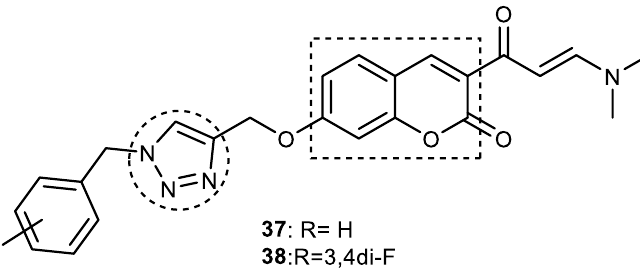
Figure 14. Chemical structure of coumarin – 1,2,3-triazole hybrids. Pourabdi et al., 2022, reported the synthesis, anti-ChE, 15-lipooxygenase (15-LOX), anti-A β aggregation, and neuroprotective activity of a novel series of 3-arylcoumarin derivatives linked to an N -benzyl 1,2,3-triazole ring system. They tried to obtain coumarin– 1,2,3-triazole hybrids capable of exhibiting LOX inhibitory activity in addition to the ChE/neuroprotection/antioxidant activity. It was hypothesized that 3-arylcoumarins with suitable hydrophobic aryl rings are more likely to bind the LOX through hydrophobic interactions [94]. Hence, in an attempt to obtain MTDLs, their group conjugated two bioac- tive moieties into one structure, viz., 3-arylcoumarin linked with N -benzyl 1,2,3-triazole bearing some pharmacophoric groups known to augment/exhibit anti-ChE activity [95]. Hybrid compounds were synthesized in four steps. Azides for the final step were generated in situ from corresponding benzyl halides. A one-pot, three-component click chemistry reaction (CuAAC) was used to synthesize coumarin-linked 1,2,3-triazole hybrids. Syn- thesized hybrids displayed very weak anti-AChE activity; however, they were found to be weak to a moderate inhibitor of eq BuChE (IC 50 = 6.7–36.5 µ M) in comparison with tacrine (IC 50 = 0.073 ± 0.009 µ M). Among the unsubstituted/substituted coumarins, the 8-methoxy group substituted coumarin, namely, 3-(4-((1-(4-chlorobenzyl)-1 H -1,2,3-triazol- 4-yl) methoxy)phenyl)-8-methoxy-2 H -chromen-2-one ( 43 ) and the 6-nitrocoumarin deriva- tive 3-(4-((1-benzyl-1 H -1,2,3-triazol-4-yl)methoxy) phenyl)-6-nitro-2 H -chromen-2-one ( 46 ), showed the best anti-BuChE activity (IC 50 = 6.7 and 6.3 µ M, respectively). Unsubstituted coumarin derivatives ( 39, 40 , and 41 ) exhibited mild BuChE inhibitory activity (IC 50 = 27.6, 36.5, and 19.5 µ M, respectively). Surprisingly, 6-bromocoumarin derivatives ( 44 and 45 ) were inactive against BuChE (Figure 15). SAR studies also indicated that changing the type/position of the electronic parameters in the benzyl fragment contributes little to the BuChE inhibitory activity, while the type of substituent (6-NO 2 , 8-OCH 3 ) on a coumarin ring can significantly influence the activity. Compound 41 (3-(4-((1-(3-methoxybenzyl)- 1 H -1,2,3-triazol-4-yl) methoxy) phenyl)-2 H -chromen-2-one) and 3-(4-((1-benzyl-1 H -1,2,3- triazol-4-yl)methoxy) phenyl)-8-methoxy-2 H -chromen-2-one ( 42 ) exhibited acceptable 15- LOX inhibition activities (IC 50 =39.1 and 41 µ M, respectively) and were found to be 1.44- and 1.79-times better than donepezil in reducing the aggregation of A β 1–42 . Their neu- roprotective effects against H 2 O 2 -induced toxicity were also stronger than the standard drug quercetin. Compound 41 also showed more activity than the positive antioxidant agent butylated hydroxytoluene (BHT). Molecular docking study results showed that the coumarin and 1,2,3-triazole rings of compounds 41 and 42 form different binding interac- tions with amino acid residues in the active site of BuChE. The N -benzyl 1,2,3-triazole of 41 bound to the catalytic triad, whereas the benzyl ring stacked with Trp82, and 1,2,3-triazole ring formed two T-shaped interactions with His438 and Trp82 residues. The coumarin ring was observed to form π stacking with Tyr332 and was leaning toward the rim of the BuChE. In the case of 42 , the coumarin moiety formed π stacking with Trp82 and lay at the bottom of the active site, while the N -benzyl 1,2,3-triazole tail was involved in H-bond formation with Asp70 at the gate of the active site